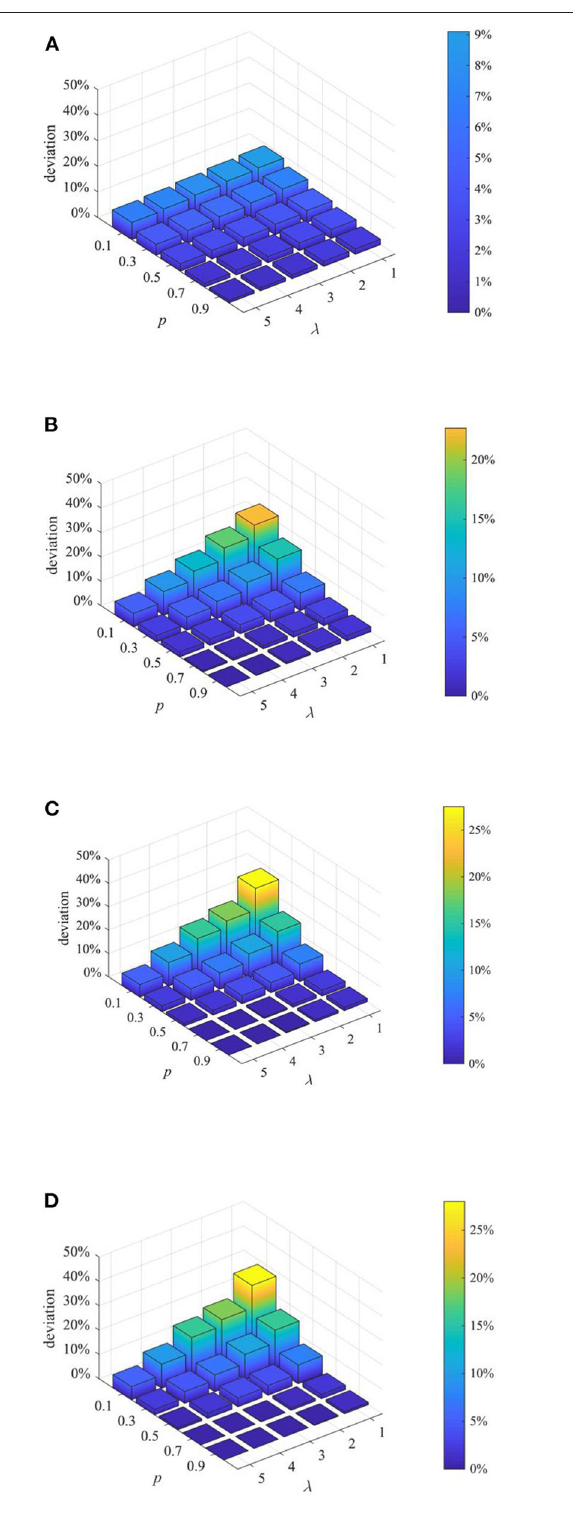
FIGURE 11 | The entire network information content deviation under different strategy combinations. (A) t = 1. (B) t = 15. (C) t = 30. (D) t =